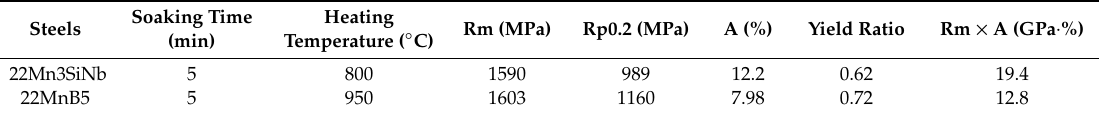
Figure 7. Mechanical properties of the two experimental steels after being heated for 3 min and 5 min, respectively. ( a ) tensile strength, ( b ) yield strength, ( c ) elongation. Table 3. Mechanical properties of two investigated steels after warm / hot